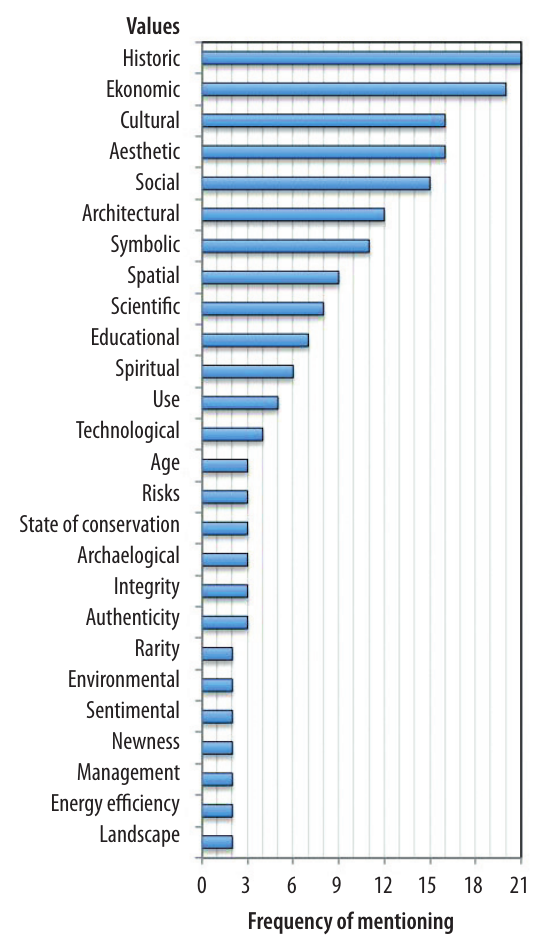
Fig. 1. Graphical presentation of frequency of records for each individual value, identified on the basis of extensive conservation literature analysis